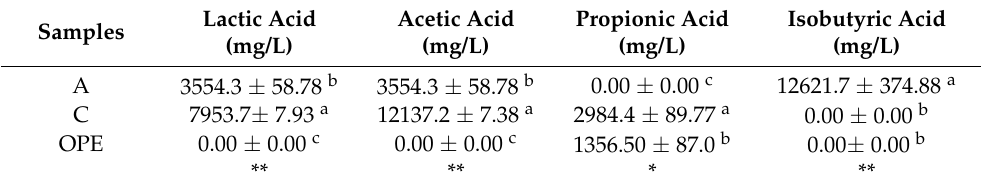
Table 3. Results of organic acids of the three tested OMWW fractions analysed by HPLC. Samples